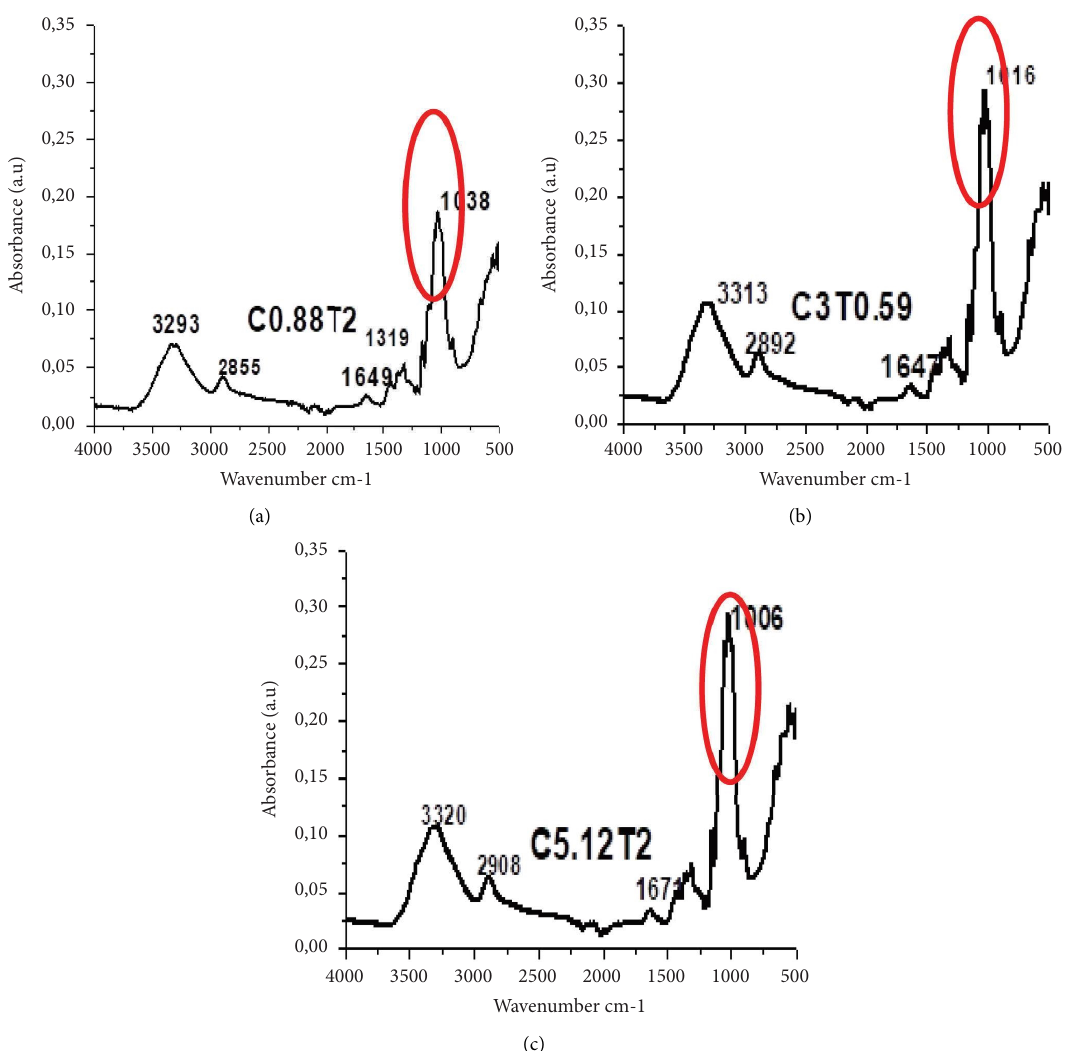
Figure 5: Comparison of wavenumbers in treatment: (a) C0.88T2, (b) C3T0.59, and (c)